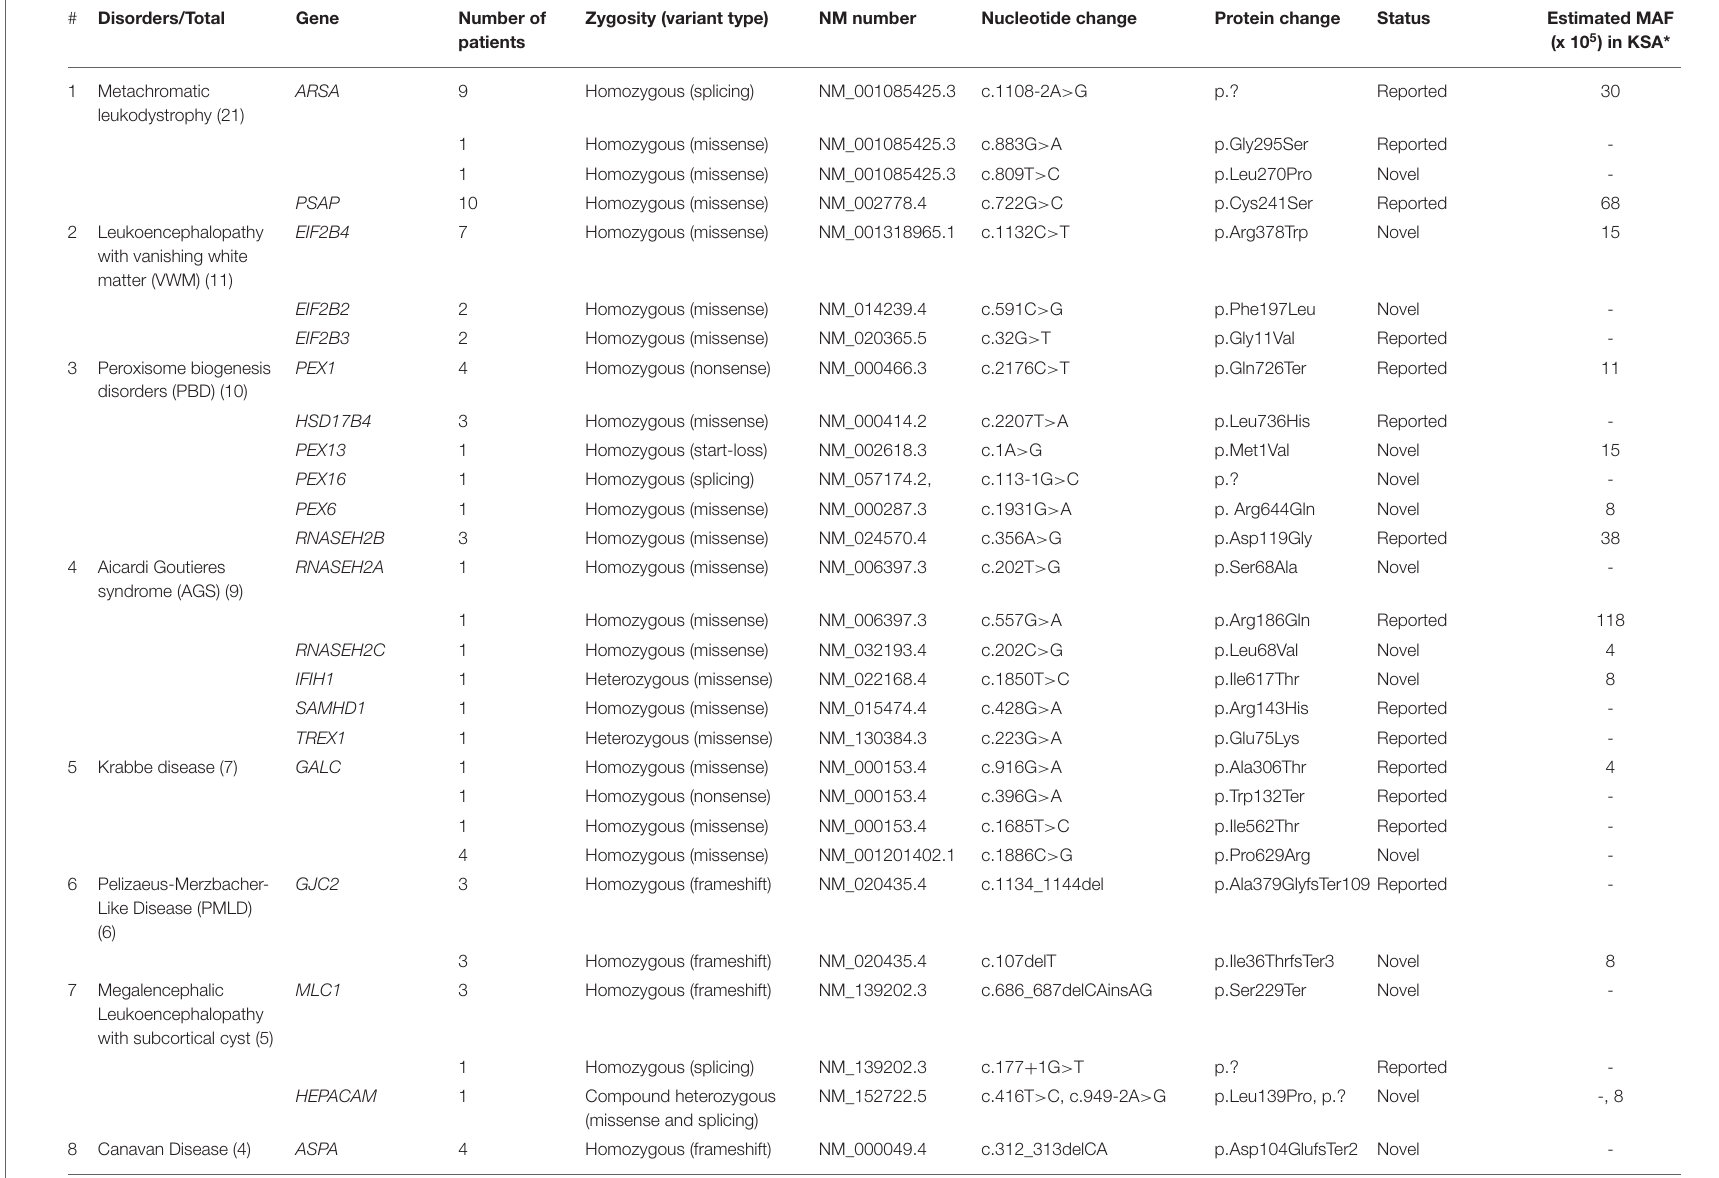
TABLE 3 | Summary of genetic